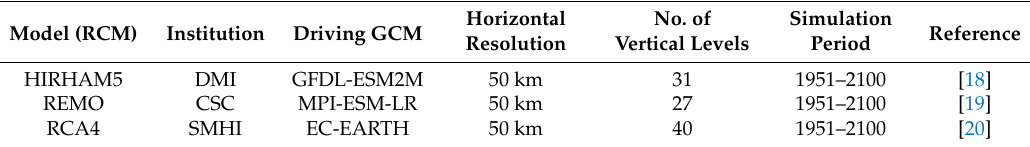
Table 1. Main characteristics of the RCM